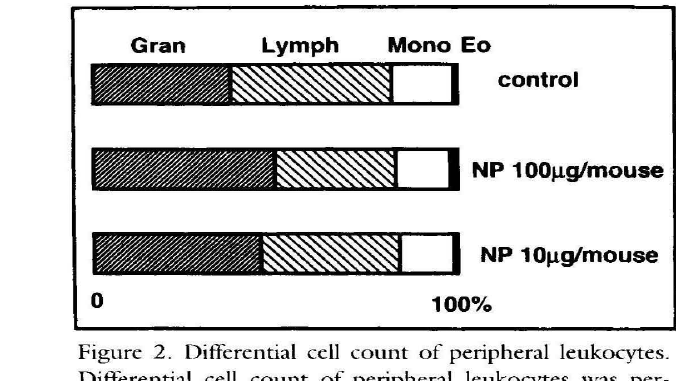
Figure 2 . Differential cell count of peripheral leukocytes. Differential cell count of peripheral leukocytes was per formed at day 7 after NP treatment.